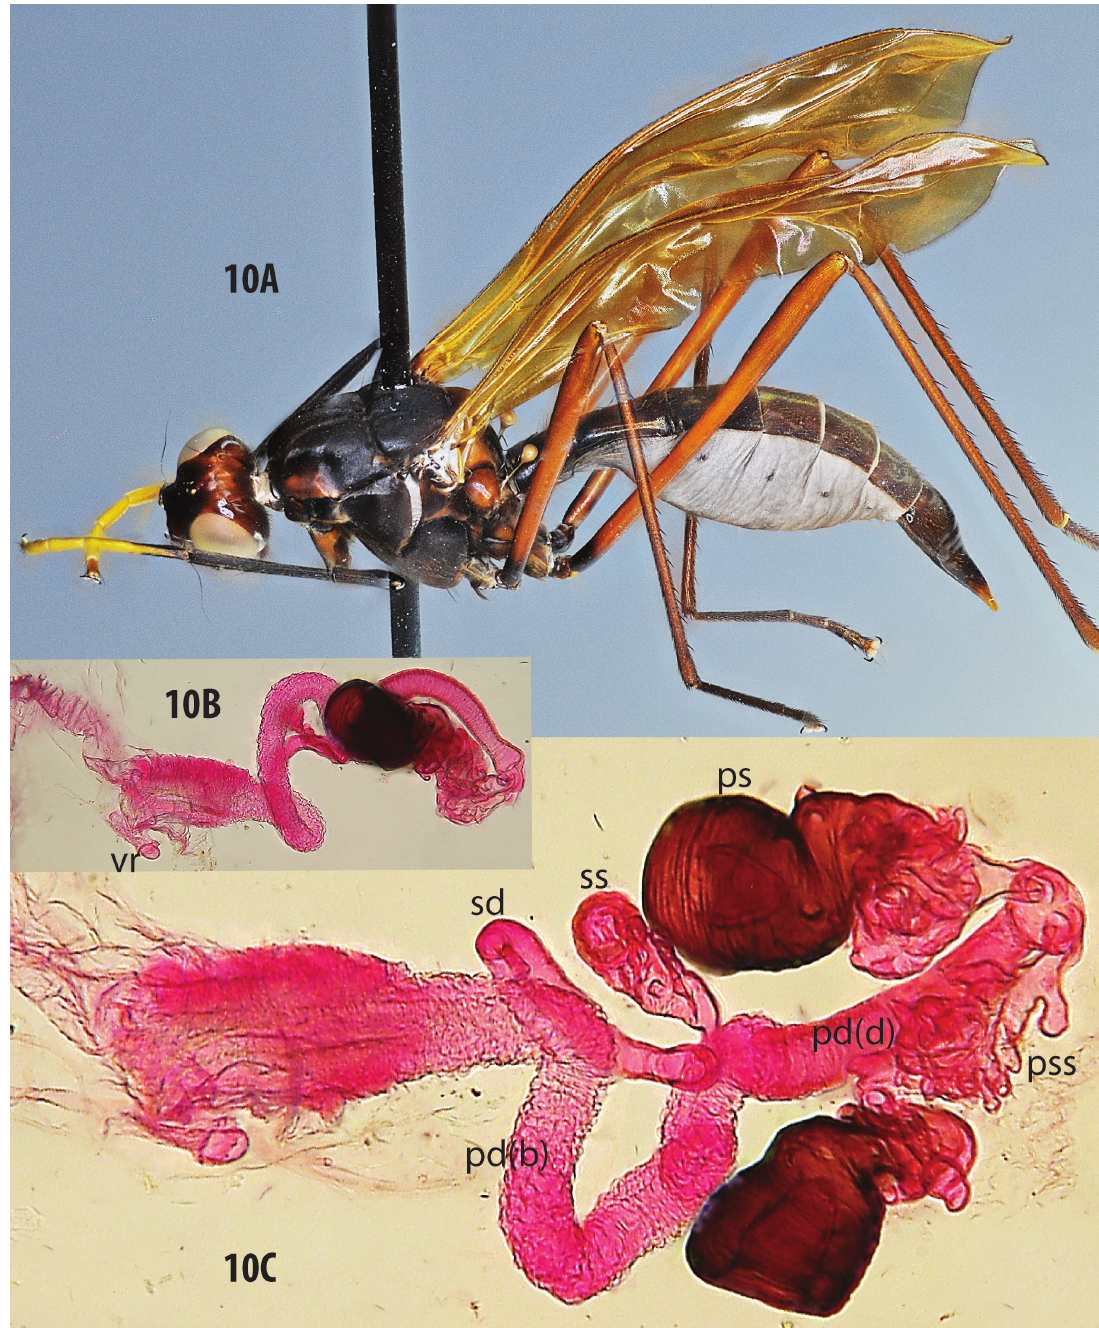
Fig. 10. Mesoconius hirsutimamma sp. nov . A . Holotype, ♀, IAVH. B–C . Spermathecae and associated structures. Abbreviations: pd(b) = paired spermathecal duct (basal section); pd(d) = paired spermathecal duct (distal section); ps = paired spermatheca; pss = paired spermathecal stem; sd = single spermathecal duct; ss = single spermatheca; vr = ventral